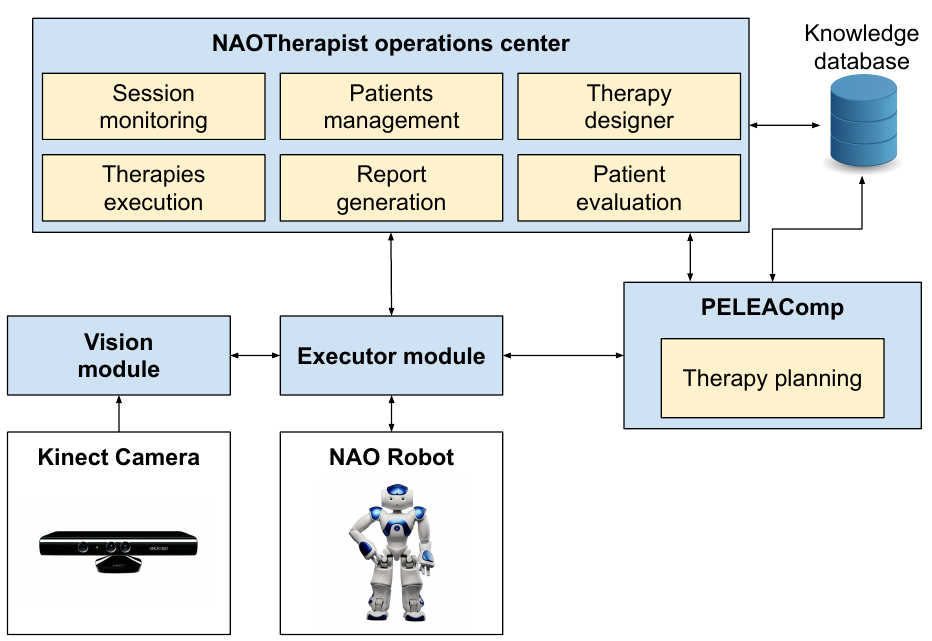
Figure 4. General diagram of the NAOTherapist